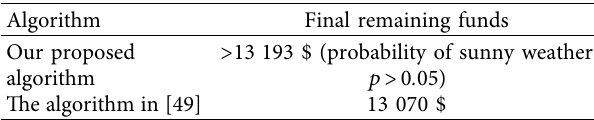
Table 12: Comparison of two algorithms in Level 4. Algorithm Final remaining funds Our proposed